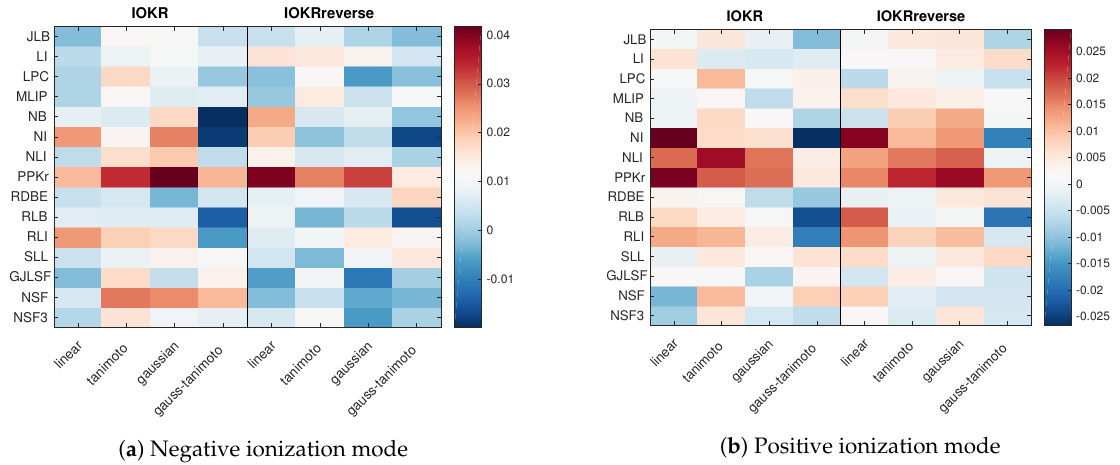
Figure 3. Heatmap of the weights learned during the score aggregation in the negative ionization mode ( a ) and the positive ionization mode ( b ). The weights have been averaged over the five cross-validation